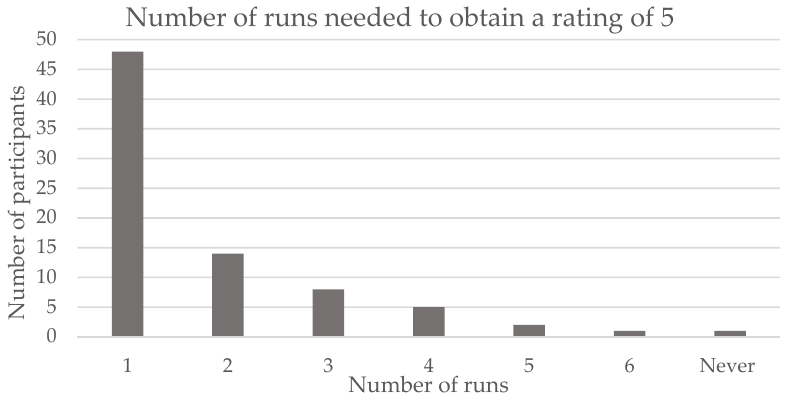
Figure 5. Number of runs needed to obtain an instructor rating of 5.